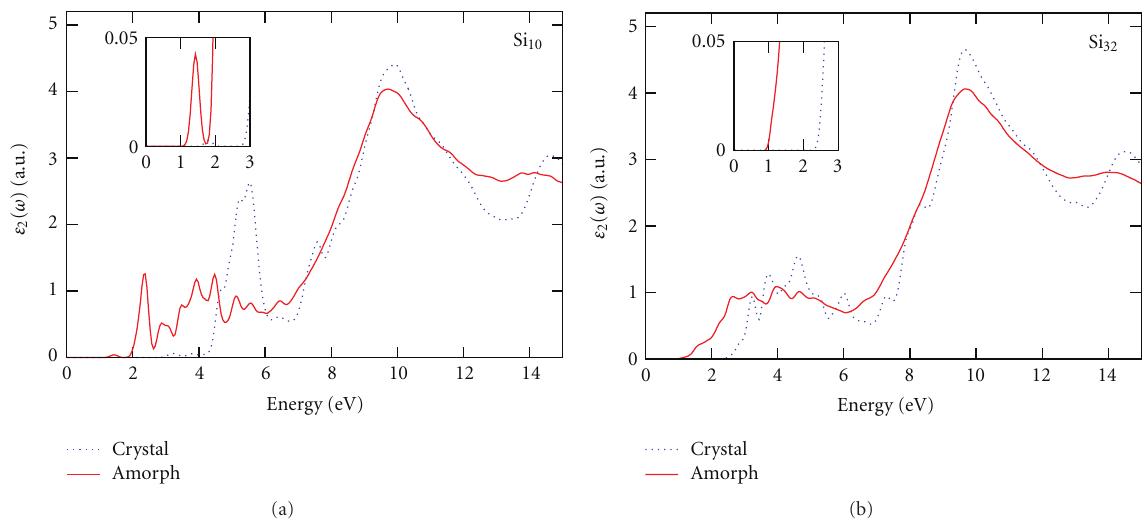
Figure 2: Imaginary part of the dielectric function at DFT-RPA level for the crystalline (dotted) and amorphous (solid) Si 10 and Si 32 embedded Si-nc [58]. The insets show an enlargement of the spectra at low energies. The spectra are per unit volume.